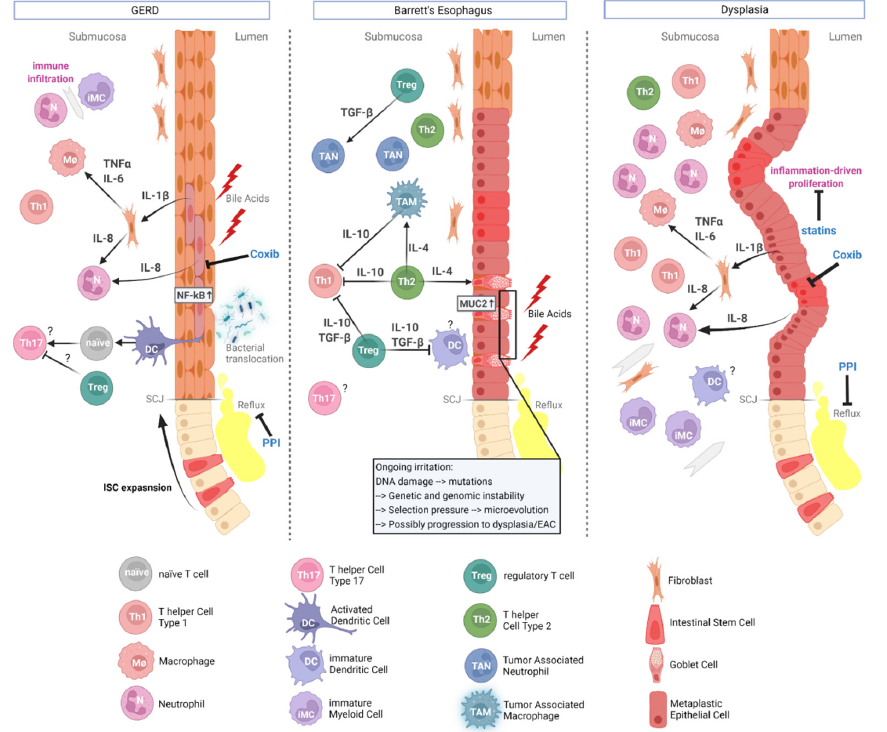
Figure 1. Immunologic networks in the progression of Esophagitis over Barrett’s esophagus to Dys- plasia. Overall, the phenotype changes from type 1 domination in esophagitis (GERD) to type 2 in Bar- ret’s Esophagus and back to type 1 in Dysplasia. Tregs may be initially protective through inhibition of tumorigenic Th 17 cells. Th 2 cells support metaplasia via IL-4, which induces goblet cell associated MUC2. Gray arrows indicate migration and question marks indicate unclear roles, as elaborated in the main text. Abbreviations: Coxib = Cyclooxygenase Inhibitor; IL = Interleukin; ISC = Intestinal Stem Cell; PPI = Proton Pump Inhibitor; SCJ = Squamo-Columnar Junction; TGF- β = Transforming Growth Factor β ; TNF α = Tumor Necrosis Factor α . Generated with